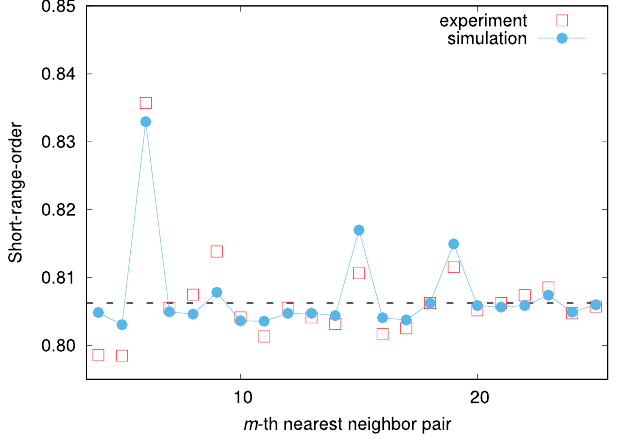
Figure 4. The SRO parameter of Mg 0.9489 (Zn 6 Y 8 ) 0.0511 for each m th-nearest-neighbor pair at T = 773 K. The broken line denotes the statistical average. If SRO is higher than average, the number of Mg–Mg and cluster– cluster pairs is larger than the number of Mg–cluster pairs. The opposite is true if SRO is lower than